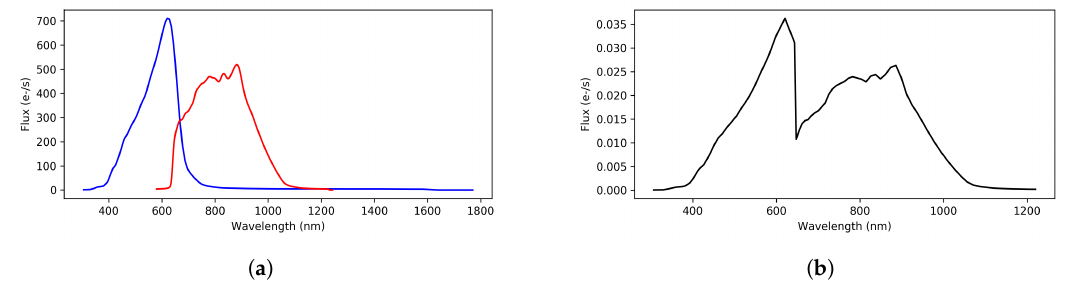
Figure 3. Gaia spectrophotometric data preprocessing for the Outlier Analysis (OA) module: the spectra provided by the Blue and the Red Photometers (BP/RP) are sanitized, downsampled, clipped, and joined into a single spectrum. Finally, the extinction is treated by applying a Cardelli extinction model [32] and the flux is normalized to unit area. ( a ) original Gaia BP/RP spectra; ( b ) preprocessed spectrum for